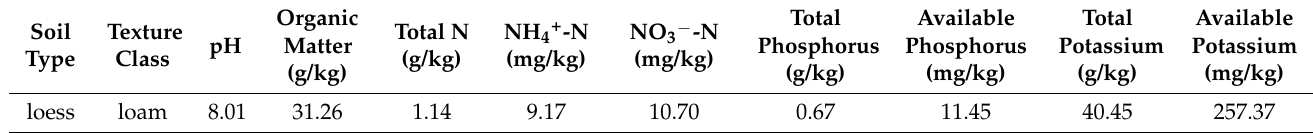
Table 1. Physicochemical properties of loess (0–0.20 m soil